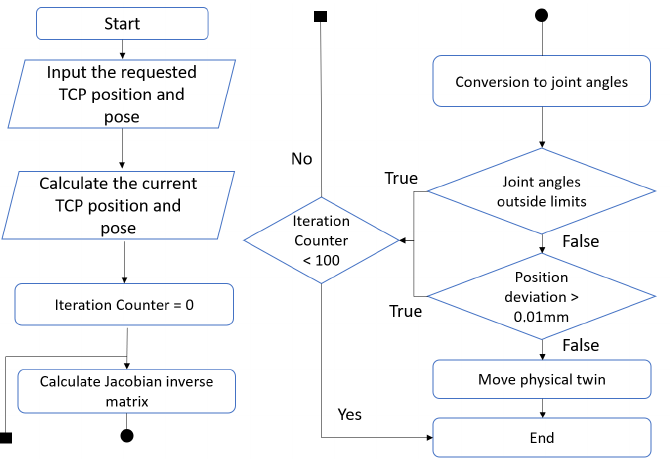
Figure 9. Flowchart of inverse kinematics